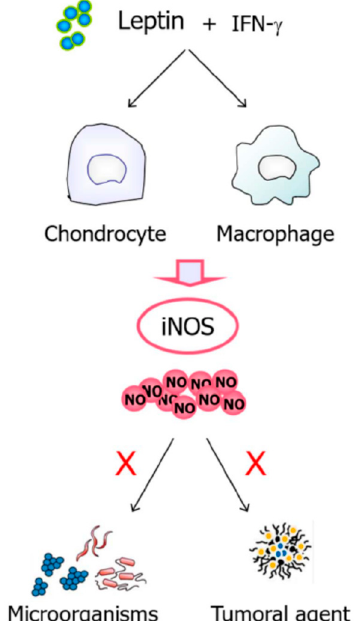
Figure 6. Leptin acts through NO in the immune response. Leptin markedly increases interferon- γ (IFN- γ )-induced NO production by increasing iNOS and COX-2 expression in macrophages and chondrocytes, playing a proinflammatory role in synergy with interleukin (IL)-1 and maintaining an inflammatory response. NO is responsible for the destruction of microorganisms and tumoral agents. Moreover, leptin stimulates GH production by peripheral blood mononuclear cells via NO-dependent pathways. COX-2, cyclooxygenase 2; GH, growth hormone, iNOS, inducible nitric oxide synthase; NO, nitric